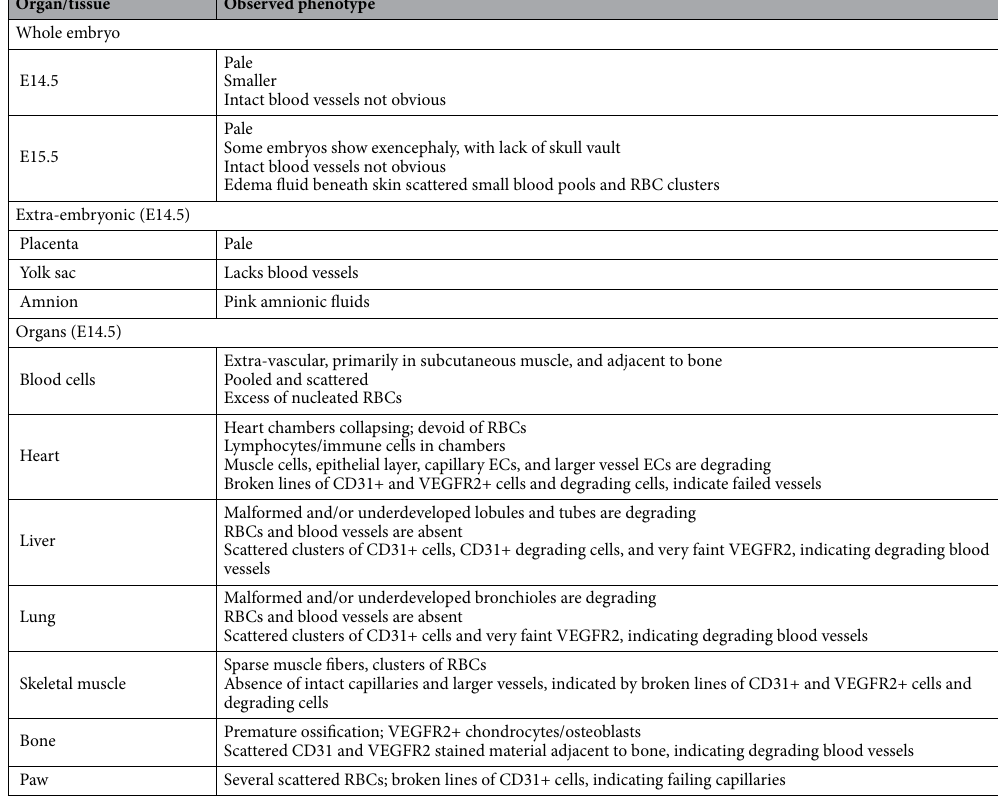
Table 1. Summary of defects observed in SAMD1 KO